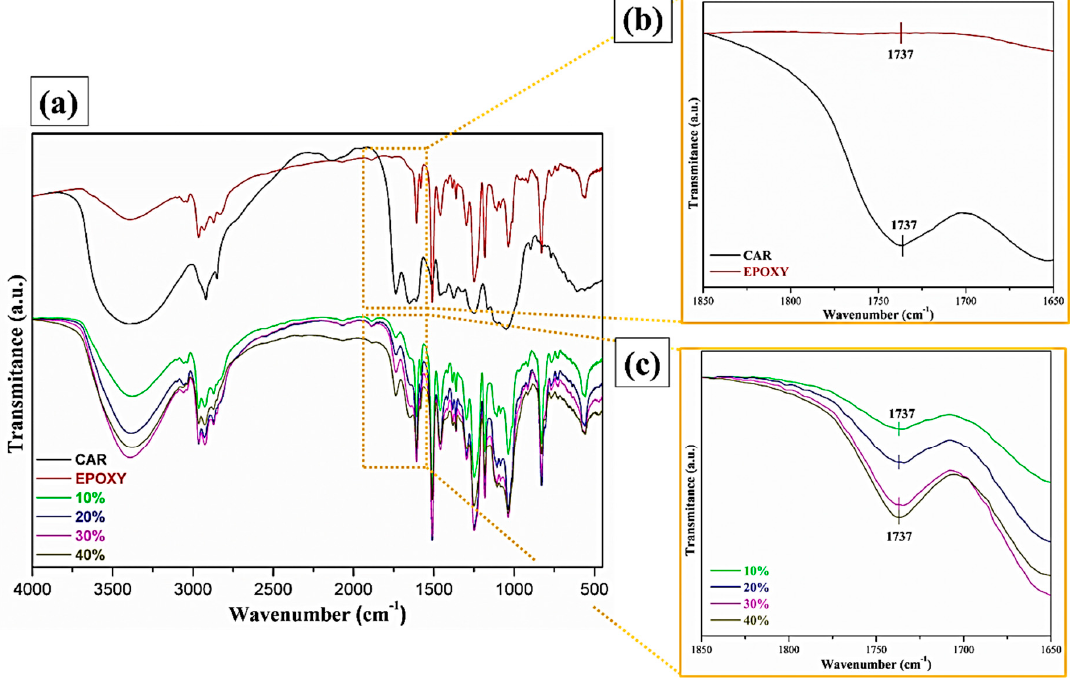
Figure 12. General Fourier transform infrared spectroscopy (FTIR) spectra for carnauba fiber, epoxy resin, and composites ( a ). Details for epoxy resin and carnauba fibers ( b ) and for the epoxy composites ( c ).